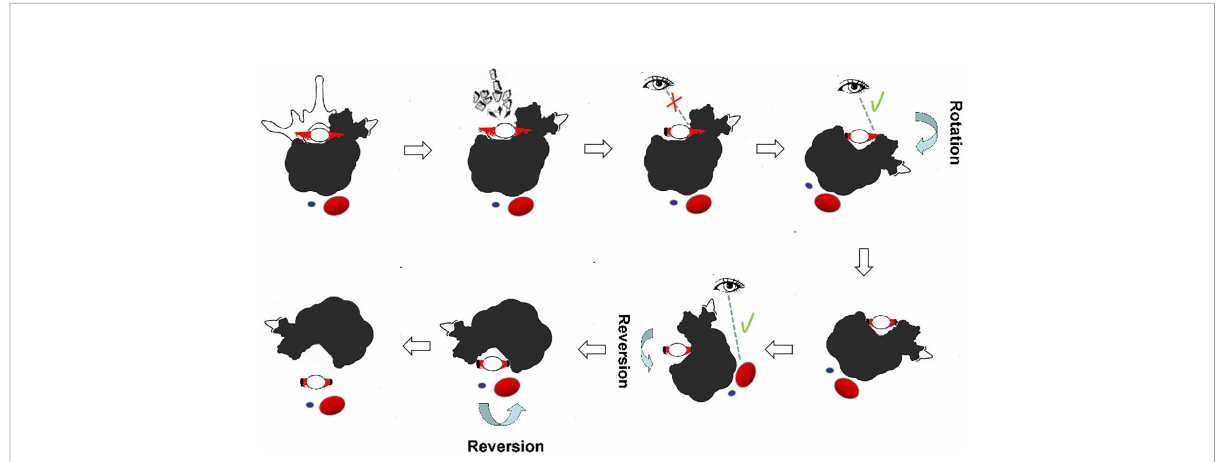
FIGURE 1 Illustration of en bloc resection using the rotation – reversion technique through a single posterior approach in the thoracic spine. A safe window was opened at the posterior arch, and nerve roots on the unaffected side were sectioned. The dura was separated from the lesion, and the nerve roots on the side covered by the tumor were sectioned under direct visualization by the rotation technique. The great vessels and surrounding structures at the ventral side of the tumor-invaded vertebrae were bluntly dissected under direct visualization using the reversion technique from the posterior approach. Reversal of the entire mass was continued until it was completely removed